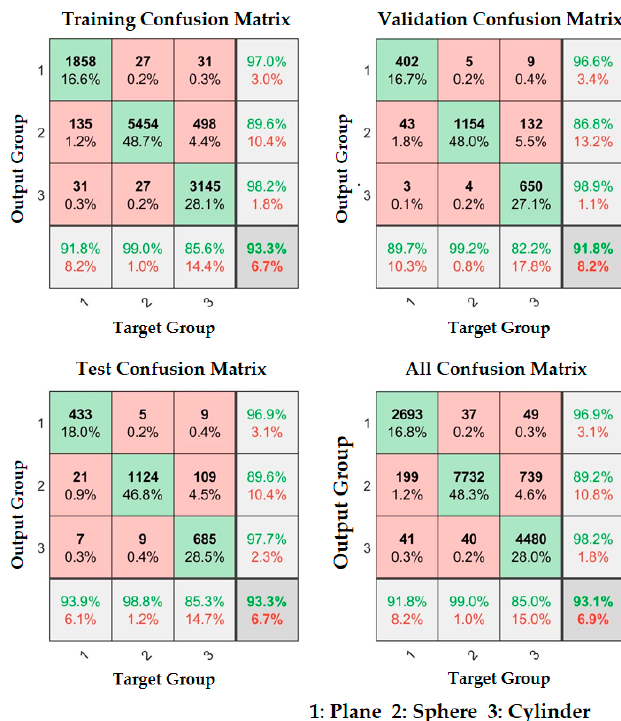
Figure 11. Object surface type classification results.